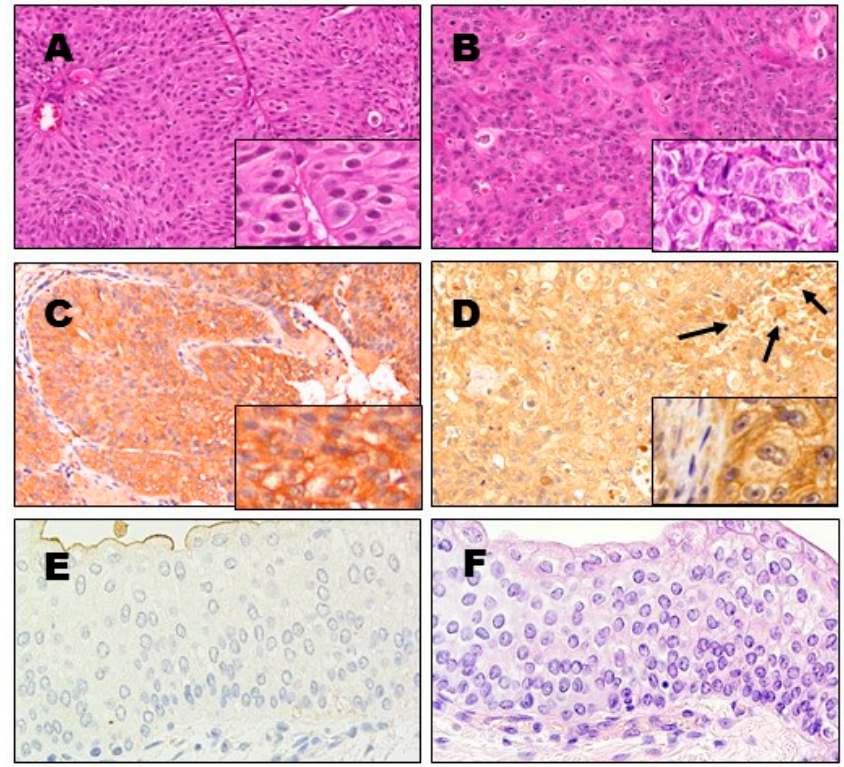
Figure 2. Expression levels of LHRH receptor protein in surgically removed human TCC bladder cancer cases detected by immunohistochemistry (IHC). ( A , B ) Hematoxylin–eosin stained sections of representative samples. ( C , D ) The corresponding IHC images for LHRH receptor expression. ( A ) shows a papillary TCC, G1 (low grade) expressing ( C ) cytoplasmic and membranous (inset) LHRH receptor protein, predominantly with score 3+ intensities. ( B ) shows an invasive TCC, G3 (high grade) with cellular pleomorphism harboring ( D ) predominantly low intensity (score 1+) but irregular expression levels for the LHRH receptor protein with a few 2+ positive cells (arrows). Insets of images are to demonstrate the cellular details and IHC staining patterns, respectively. ( E , F ) Images of normal urothelial mucosa showing no immunohistochemically detectable LHRH receptor protein expression ( E ) albeit trace apical positivity can be recognized (light brown staining at upper left), most likely reflecting background staining. ( F ) is a corresponding hematoxylin–eosin stained image of the normal urothelium for cellular detail. ( Original magnifications for images A–D: 200 × ; insets and images E–F: 400 ×